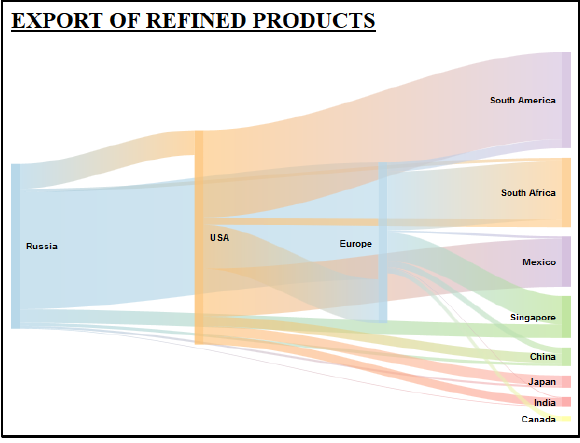
Figure 12. Export of refined products from major